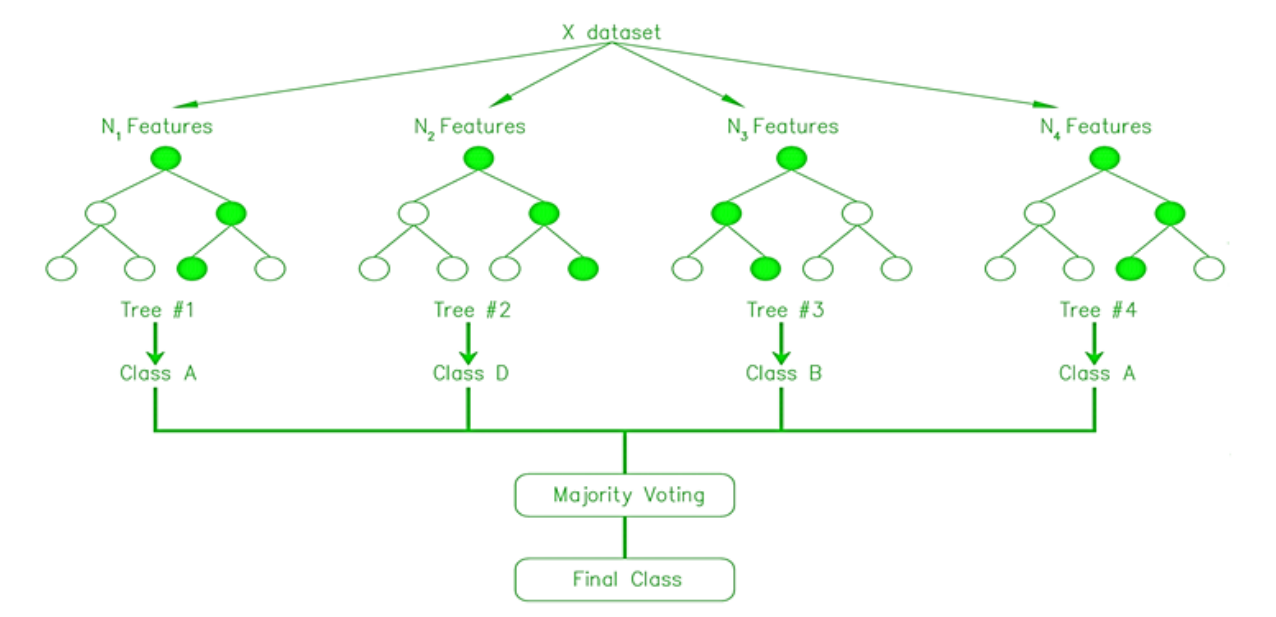
Figure 14. Basic architecture of the Random Forest (RF) model [17,57].